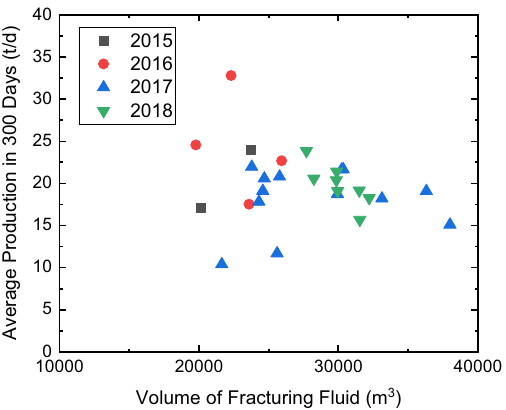
Figure 15. Cross plot of total fracturing fluid volume and average annual production of experimental wells in 4 years.